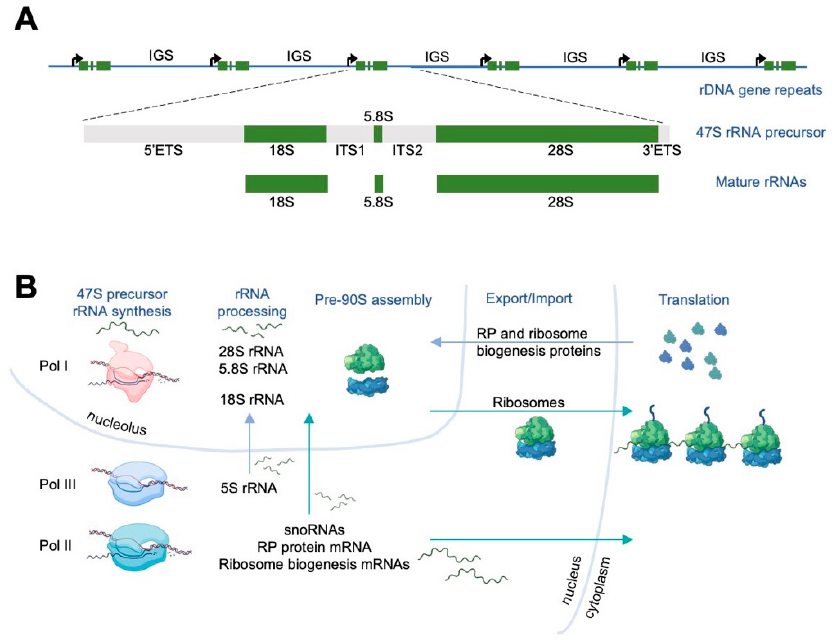
Figure 1. Ribosome biogenesis and activities of RNA polymerases. ( A ) rDNA gene repeats and the Pol I transcribed rRNAs. ( B ) Three polymerases contribute to ribosome biogenesis.